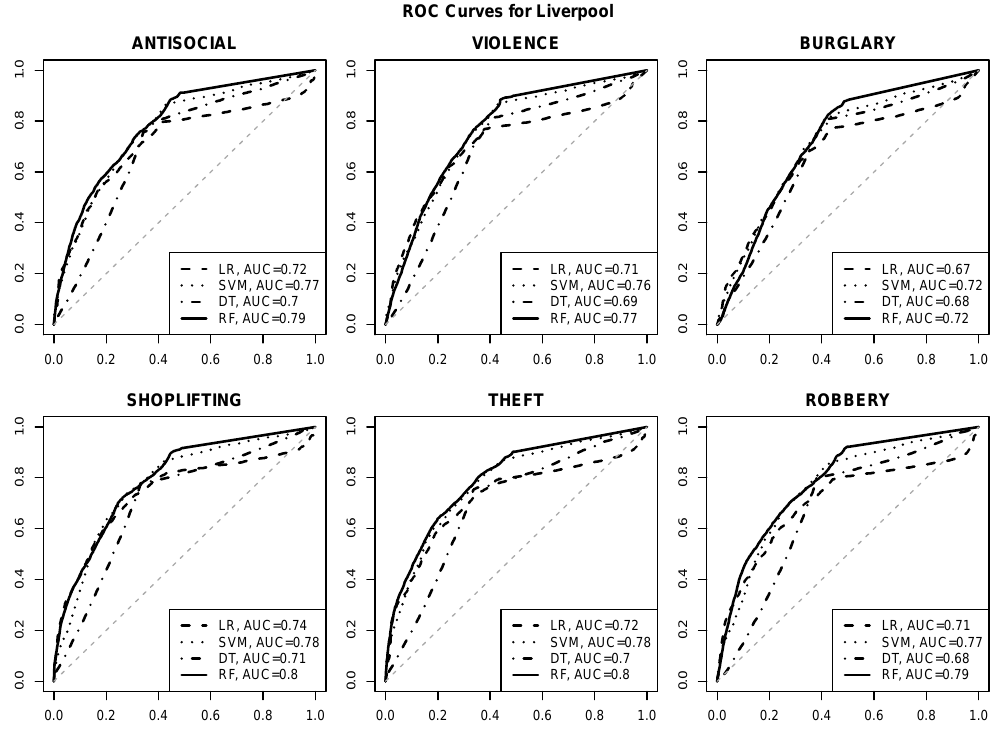
Figure 7. The ROC curves for crime risk prediction in